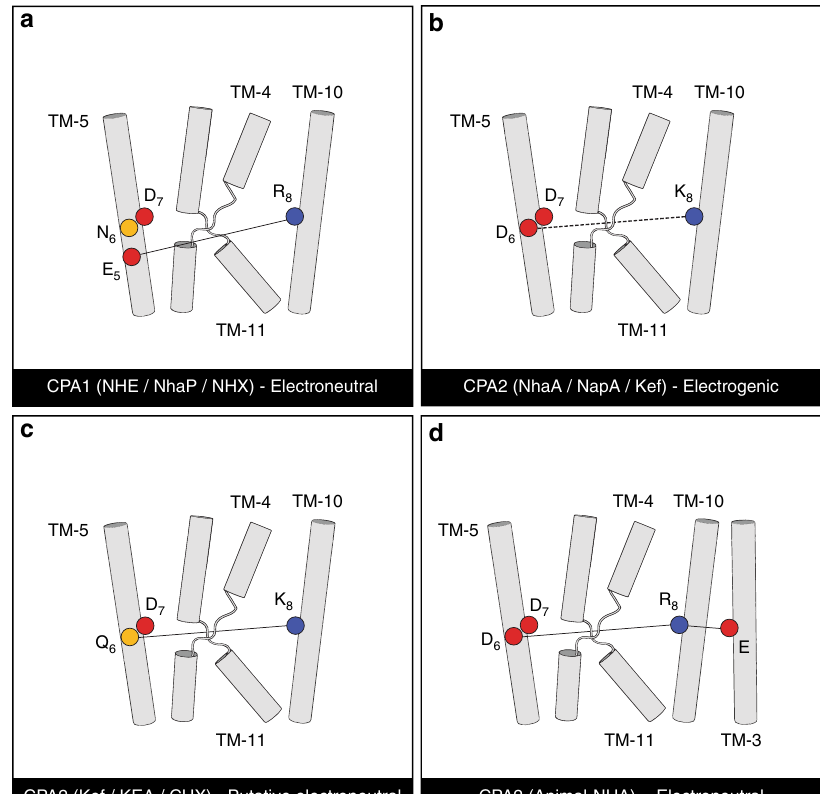
Fig. 7 A proposed model of electroneutrality versus electrogenicity. The four main variations of the putative interaction between the conserved polar residues on TM-5 and TM-10 are shown. Helices are numbered according to EcNhaA ’ s topology. The relevant residues are shown as circles, with acidic in red, basic in blue, and polar in yellow. Interactions that are expected to remain intact throughout the transport cycle according to the proposed model are marked with solid lines in a , c , d , and the interaction that would alternate is marked with a dashed line in b . a The electroneutral CPA1 subtree would feature a salt bridge between arginine in position 8 and glutamate in position 5. The protonation state of these residues would be fi xed, while that of D 7 would change upon proton transport. b Electrogenic CPA2s, characterized by acidic residues in positions 6 and 7, presumably interacting with the two protons, and a basic residue in position 8. Upon interacting with a proton, D 6 would alternate between salt bridging and hydrogen bonding with K 8 . c Putative electroneutral transport by CPA2s that lack the acidic residue in position 6. Positions 6 and 8 would hydrogen bond with each other. Similar to electroneutral CPA1s, the protonation state of these residues would be fi xed, while that of D 7 would alter upon interaction with the proton. d Electroneutral mammalian NHA-like CPA2s, surprisingly featuring two acidic residues at positions 6 and 7, similar to the electrogenic CPA2s shown in b . This group also includes an arginine at position 8 that is prevalent in electroneutral CPAs, and a uniquely conserved glutamate on TM-3 that potentially could salt bridge with each other. This slight change in the dielectric environment of D 6 could, theoretically, prevent its protonation and deprotonation, resulting